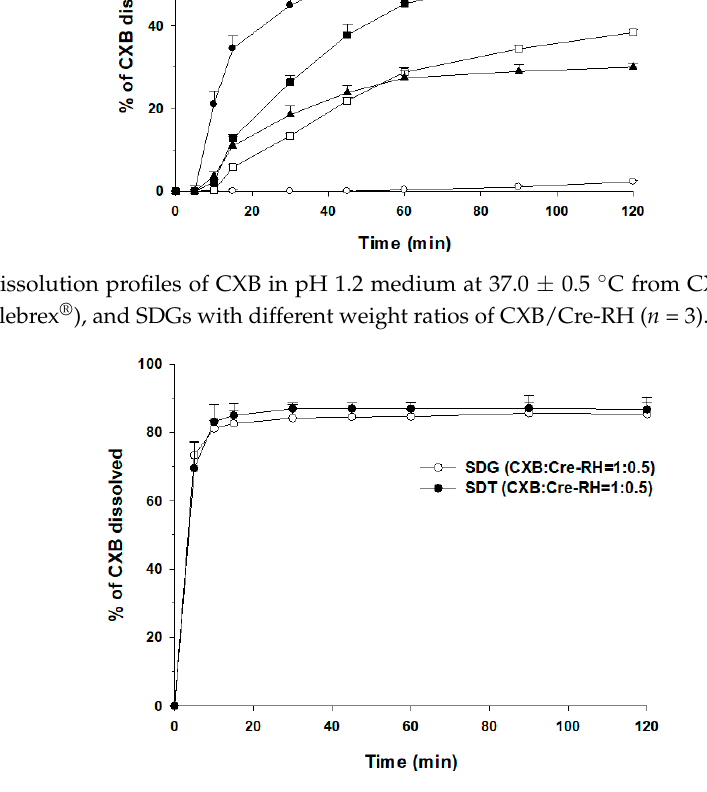
Figure 4. Dissolution profiles of CXB in pH 1.2 medium (sodium laurel sulfate (SLS) 0.5%) at 37.0 ± 0.5 °C from SDG and SDT ( n = 3).